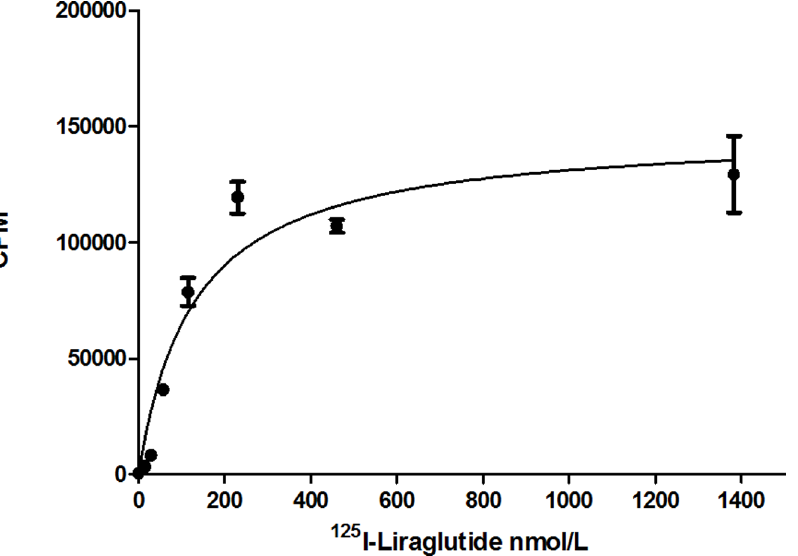
Figure 1. Saturation curve. The equilibrium dissociation constant K d for the binding between 125 I-liraglutide and the GLP-1 receptors of INS-1 cells was 128.8 6 30.4 nmol/L, and the maximum binding constant B max was (1.50 6 0.23) 6 10 5 . Error bars represent 1 SD of the mean(N=3).